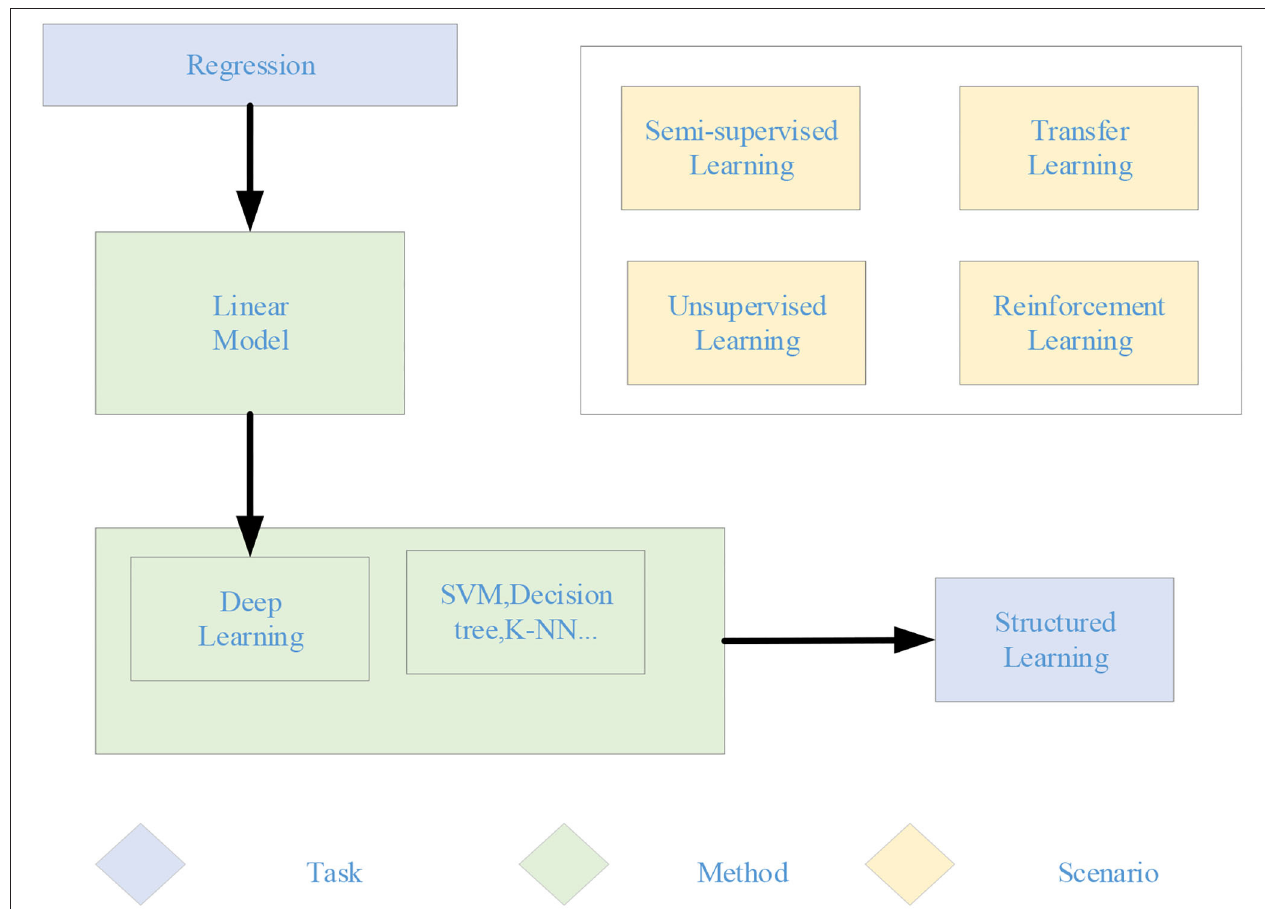
FIGURE 2 | Roadmap for machine